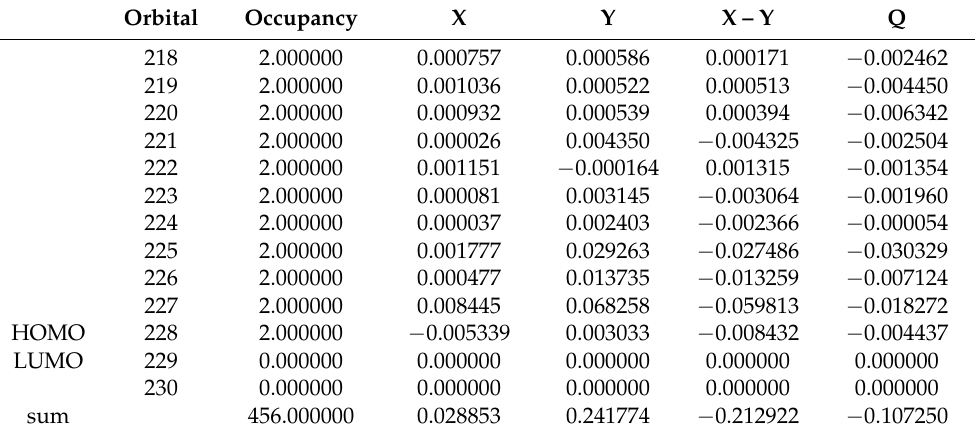
Table 4. The natural bond orbital (NBO) and the natural resonance theory (NRT) analysis for R ′ Tl ≡ PR ′ molecules that feature ligands (R ′ = SiMe(Si t Bu 3 ) 2 , Si i PrDis 2 , Tbt, and Ar*) at the dispersion-corrected M06-2X/Def2-TZVP level of theory (1,2) .